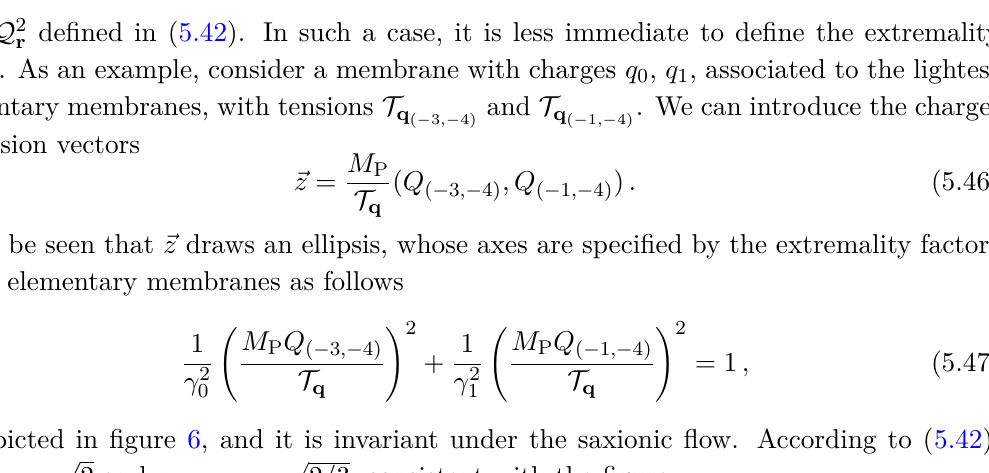
Figure 6 . The charge-to-tension ratios of two non mutually BPS